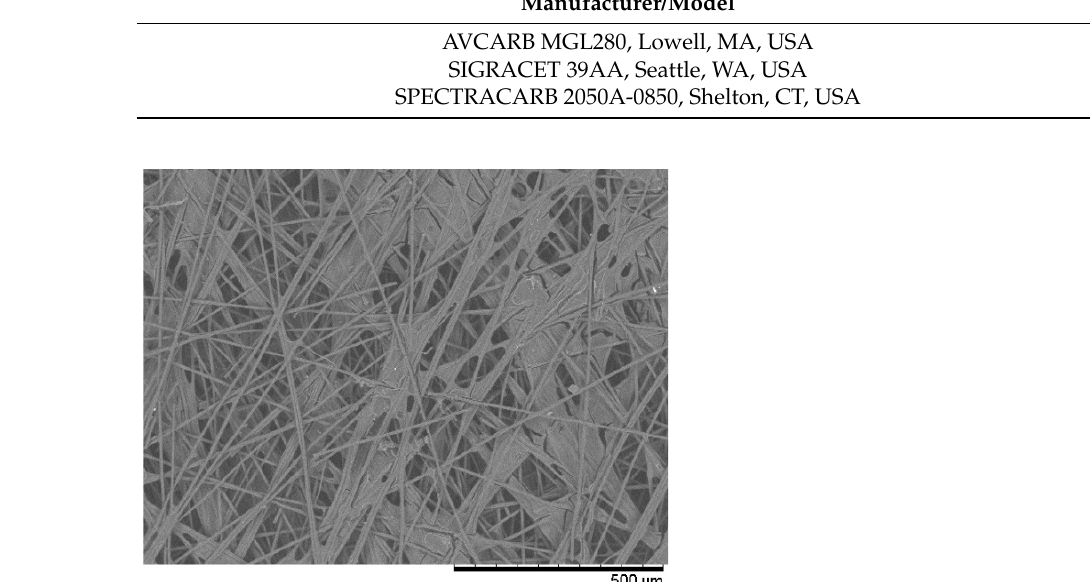
Figure 1. SEM (Hitachi ® TEM3000, Tokyo, Japan, 15 kV) image of AVCARB GDL